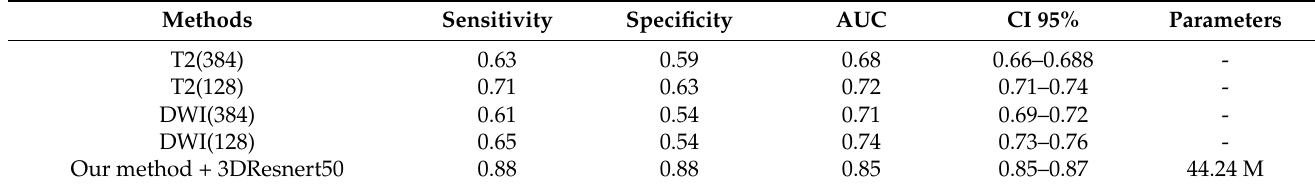
Table 3. Comparison experiments of the original 3D sequence (input sizes were 384 × 384 and 128 × 128,